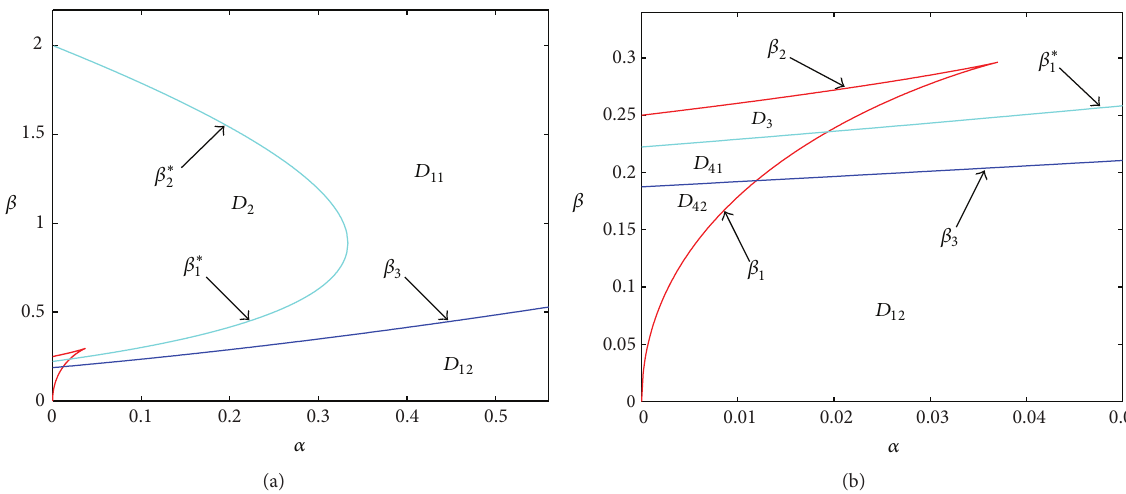
Figure 3: Bifurcation diagram of positive equilibrium in the 𝛼 - 𝛽 plane. 𝛽 = 𝛽 3 divides 𝐷 1 and 𝐷 4 into 𝐷 11 , 𝐷 12 and 𝐷 41 , 𝐷 42 , respectively.